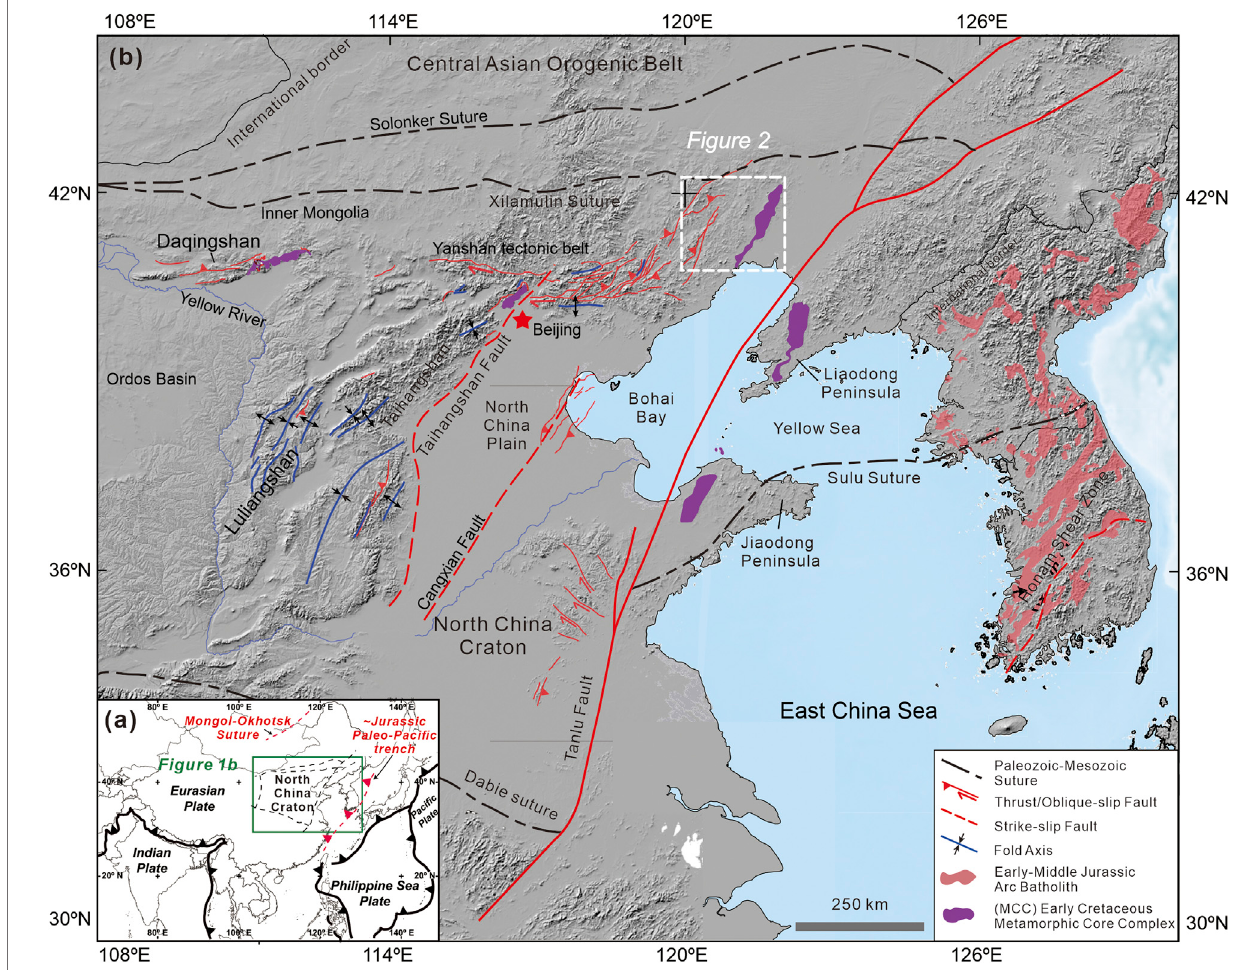
FIGURE 1 | Tectonic sketch with digital elevation map of the North China Block and adjacent regions. (A) Inset map of tectonic sketch of northeastern Asia. (B) Simpli fi edtectonicmapandtheMCCdistributionofNorthChina,showingthecontinents,suturezones,majorfaults,andlocationofthestudyarea(afterClinkscalesand Kapp,